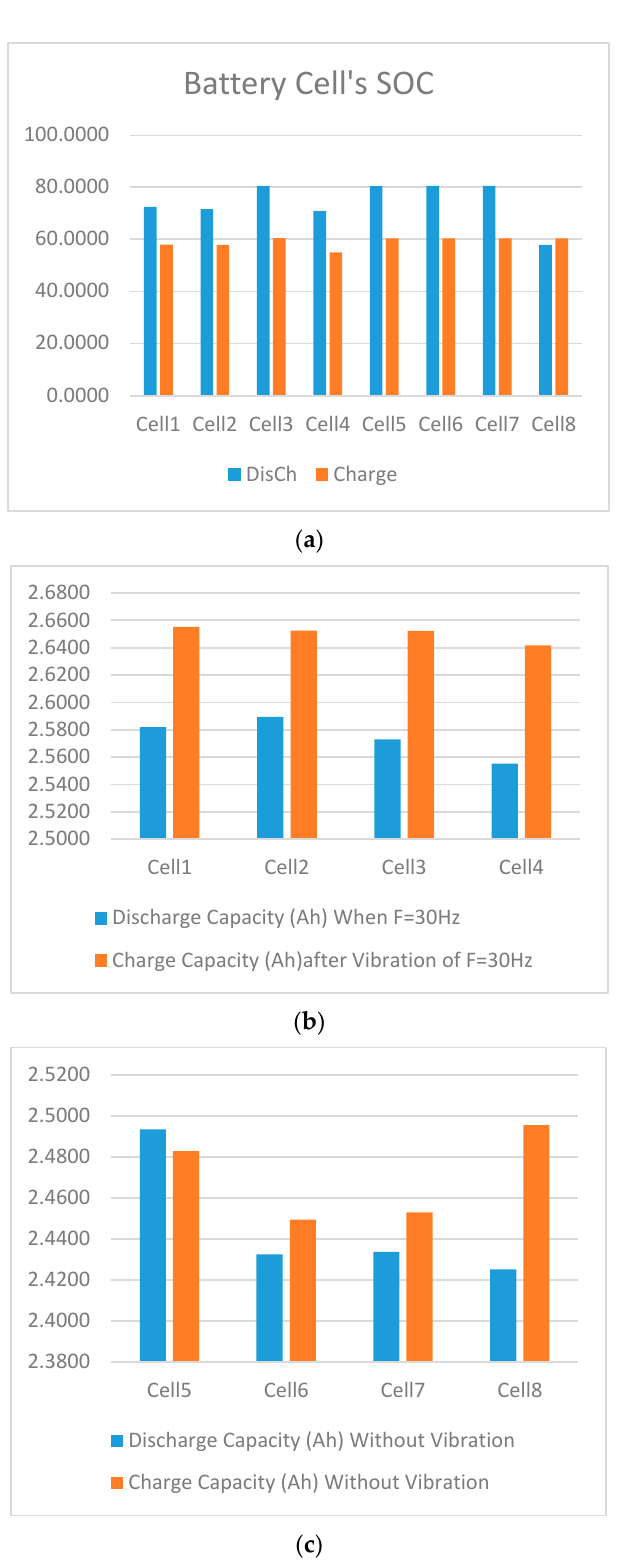
Figure 11. Effects of vibrations on battery state of charge-discharge capacity: ( a ) HPPC test for battery cell SOC after vibration F = 10 Hz stopped; ( b ) battery cell charge-discharge capacity after and before vibration F = 30 Hz; ( c ) battery cell charge and discharge capacity without vibration.